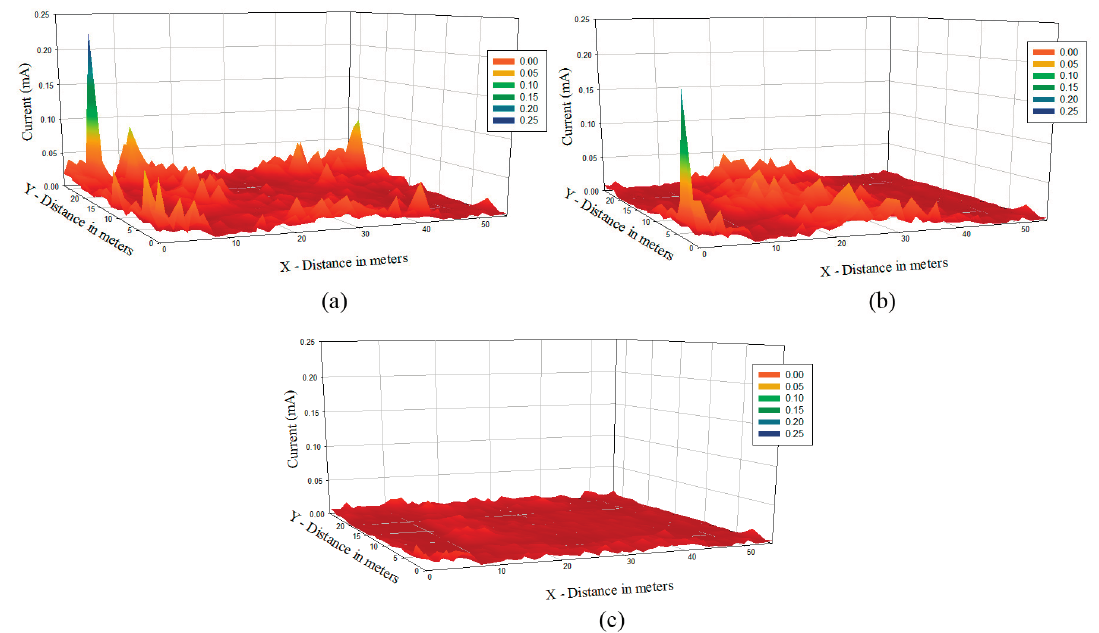
Figure 13. Current consumption in all over the scenario for the cases of three ( a ); four ( b ) and eight ( c )